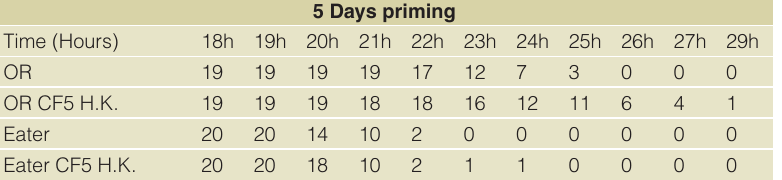
Table S5. Survival kinetics of wt and cellular response deficient flies 5 days post priming with heat-killed Pseudomonas aeruginosa CF5. Wild type Oregon R (OR) and Eater mutant uninfected flies (n=19, n=20) and primed with heat-killed (H. K.) CF5 bacteria (n=19, n=20) were inoculated at day 5 with PA14. Top row numbers indicate the time in hours post challenge whereas lower rows indicate the corresponding number of surviving flies in naive and primed flies respectively for each genotype. Sample size is indicated at 18h.